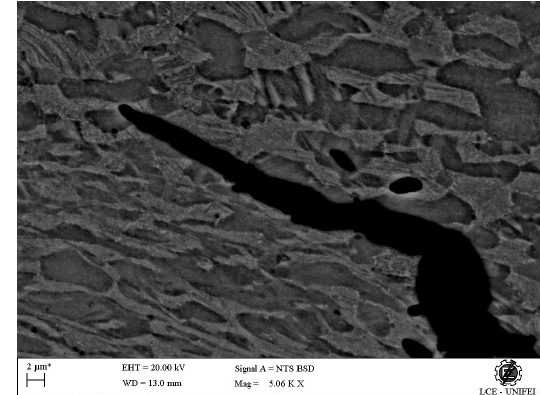
Figure 8. DA Sample: Dimples in Central Region.